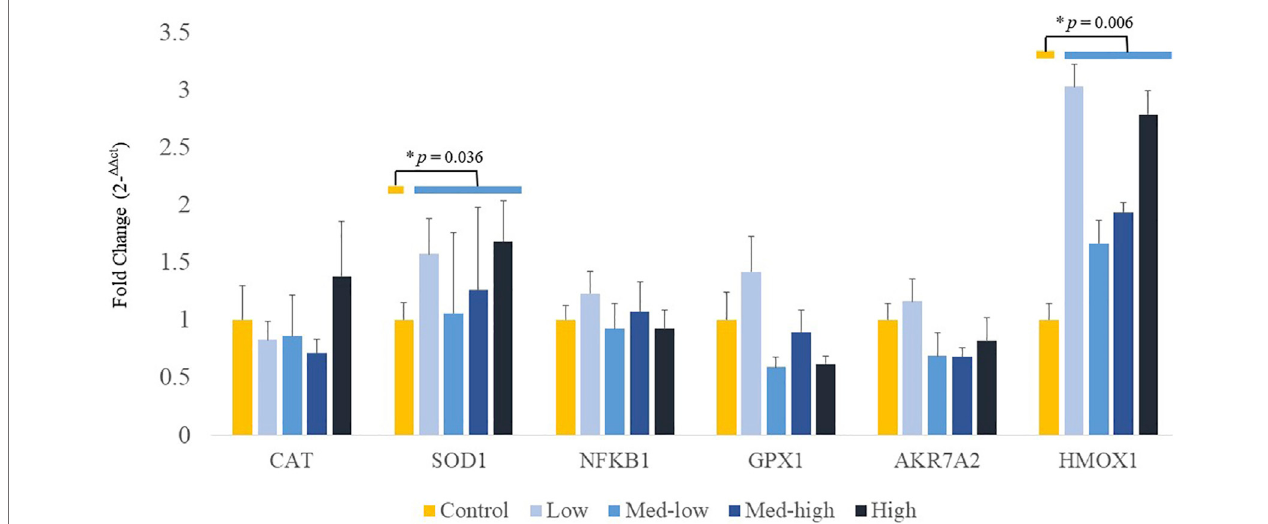
FIGURE3 | Effectsofincreasing oocysts dose of Eimeria mix on the expression ofantioxidant-related transcript genesin bone marrow ofbroilers. Low, the lowest challenge dose; Med-low, the medium-low challenge dose; Med-high, the medium-high challenge dose; High, the highest challenge dose. CAT, catalase;